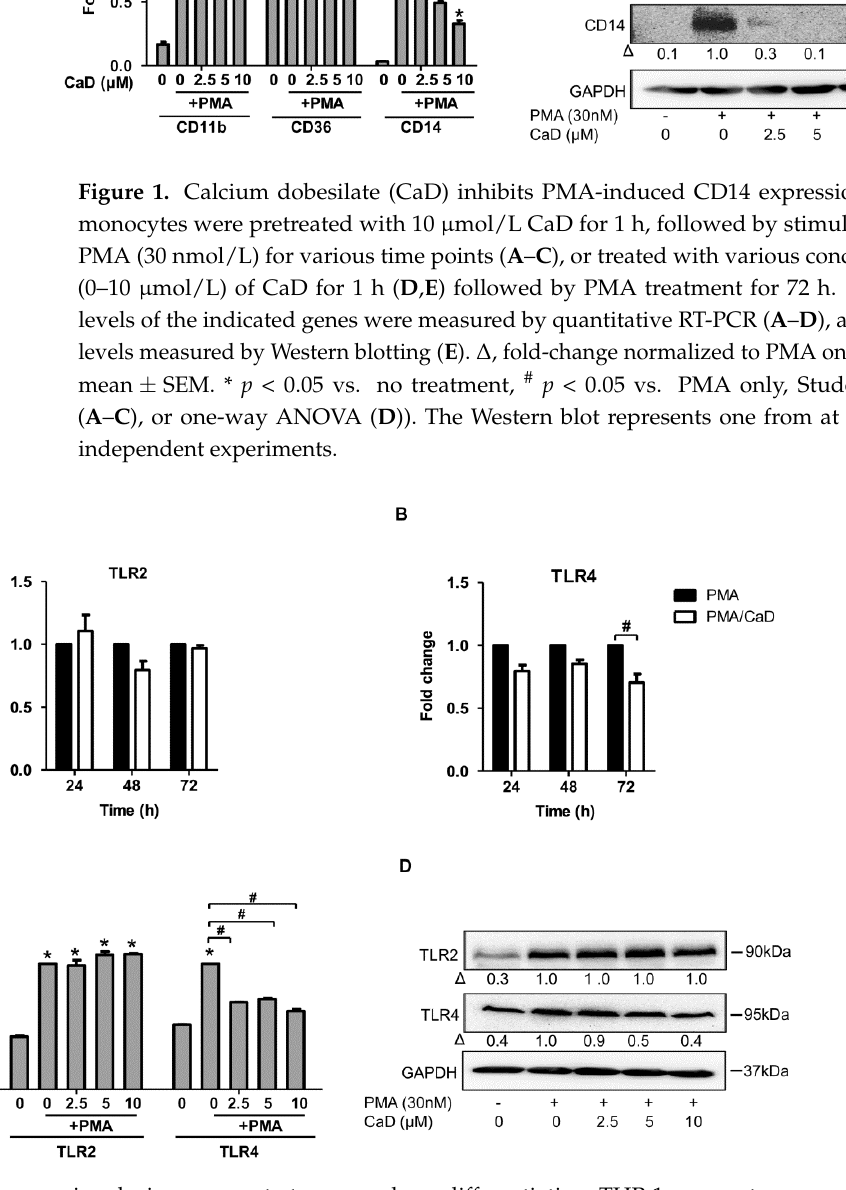
Figure 2. CaD on TLR4 expression during monocyte-to-macrophage differentiation. THP-1 monocytes were